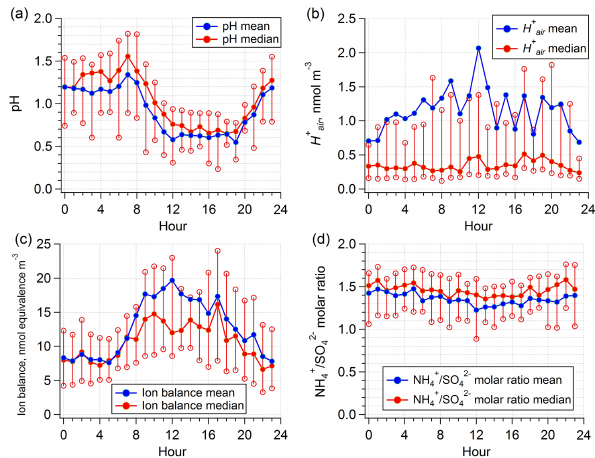
Figure 4. CTR (SOAS) diurnal patterns of calculated pH based on total predicted water ( W i + W o ) (a) , H + II (b) , ion balance (c) , and NH + and median values are shown, together with 25 and 75% quantiles marked as non-filled circles.